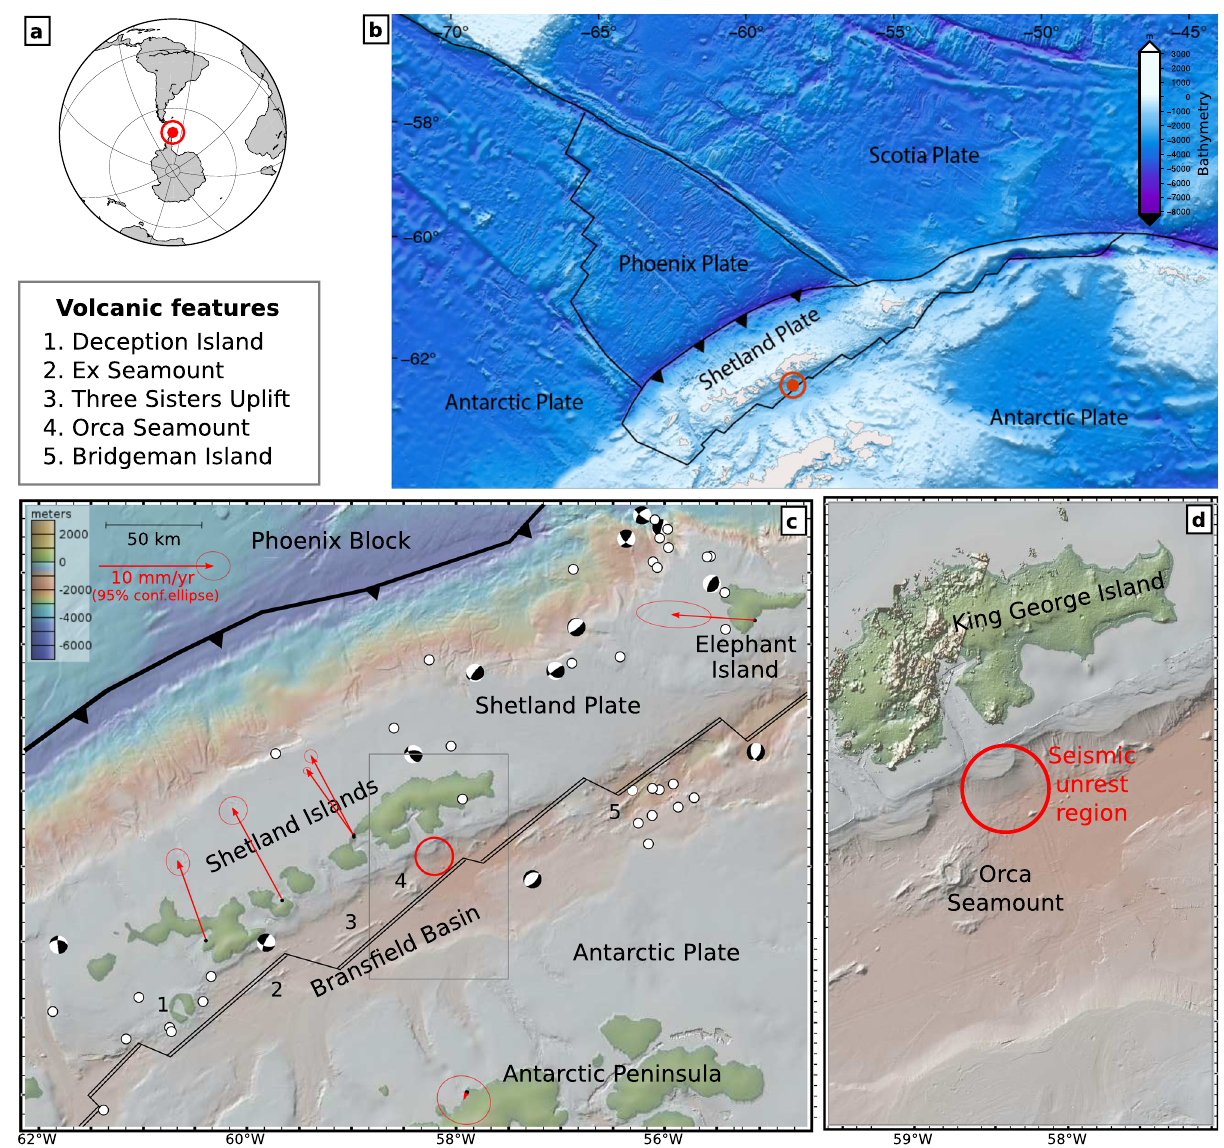
Fig. 1 South Shetland Island map. a Globe showing the location of the study region (red circle). b Regional map showing the tectonic setting (red circle denotes the location of the swarm). c Map of the Brains fi eld Basin, between Shetland Islands and Antarctic Peninsula. The regional seismicity was moderate prior to the unrest (white circles are earthquakes with magnitudes M5 + from the USGS catalog in the period 1971 – 2020, focal mechanisms are centroid moment tensor solution from the Global CMT catalog in the period 1976 – 2020). Red arrows indicate the background horizontal ground velocity relative to Antarctica at GNSS sites 35 showing NW-SE extension in the Brans fi eld Strait (ellipses show 95% con fi dence regions 35 ). A rectangle denotes the extent of the local map (panel c ) and a red circle the average location of the unrest seismicity (based on the USGS seismic catalog). Major regional tectonic features are the subduction of the Phoenix Block (the thick solid line marks the Phoenix-Shetland plate boundary 79 ) and the active rift along the Brans fi eld Basin (thin double black line and single line mark active ridge and transform fault segments, respectively, after the University of Texas Institute for Geophysics, UTIG, database). d Local map showing the bathymetric details and the Orca seamount building next to the region of the unrest (red circle). Panels c and d have been plotted with GeoMapApp (www.geomapapp.org) 80 , using the Global Multi-Resolution Topography (GMRT). positive isotropic component (Supplementary Figs. 7, 8), imply- GNSS (stations DAL5, UYBA) and InSAR data along King George ing a combination of shear and opening tensile failures 33 . Island coastline show a transient surface deformation from August The application of template matching techniques bridges the 2020 and persisting over months superposed to the background regional and local analyses (Supplementary Note 7, Supplemen- spreading rate, which we estimate as 2.1 cm/yr at UYBA. Ice cover tary Fig. 9, Supplementary Dataset 3): given their waveform prevents the InSAR analysis within the island. The transient, similarity we attribute the focal mechanism and location of the quanti fi ed after accounting for the slow spreading of the Brans fi eld respective templates to the newly detected events 34 (Supplemen- rift at GNSS stations 35 , indicates continuous ~N62.9°W horizontal tary Note 8, Supplementary Figs. 10, 11). The overall temporal motion, away from the seismogenic region (Fig. 3, Supplementary evolution depicts an alternation of strike-slip and normal faulting Fig. 13, Supplementary Note 9), reaching 10.7 ± 1.0 cm and earthquakes and helps to track the migration of seismicity (Fig. 3, 6.4 ± 1.3 cm over 6 months at DAL5 and UYBA, respectively. A Supplementary Figs. 11, 12). minor uplift of 1.3 ± 0.2 cm is resolved at DAL5. COMMUNICATIONS EARTH & ENVIRONMENT| (2022) 3:89